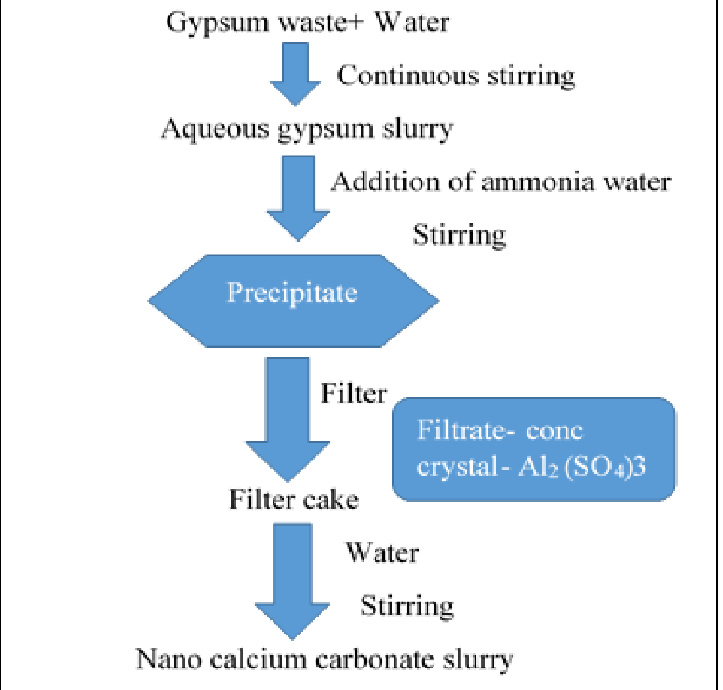
Figure 8. Steps involved in the synthesis of calcium carbonate nanoparticles from gypsum waste.